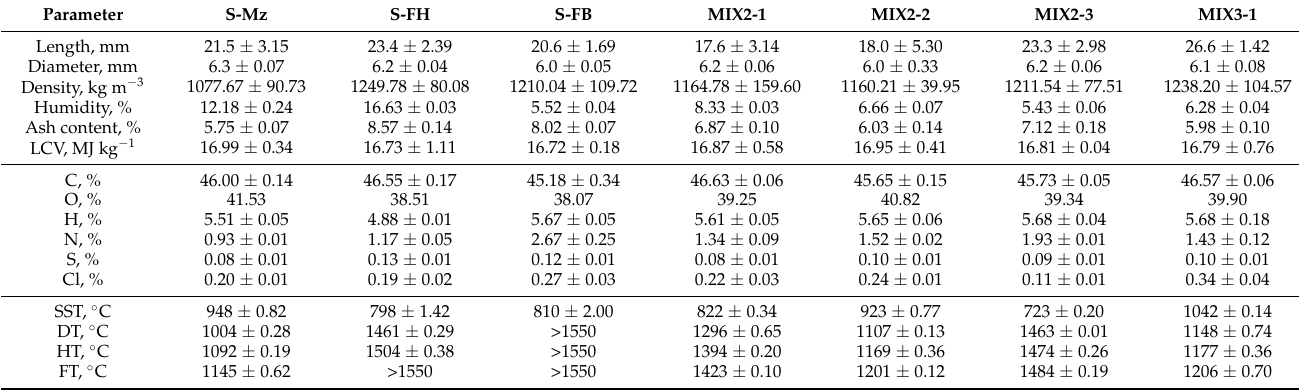
Table 2. Main characteristics of produced multi-crop plant